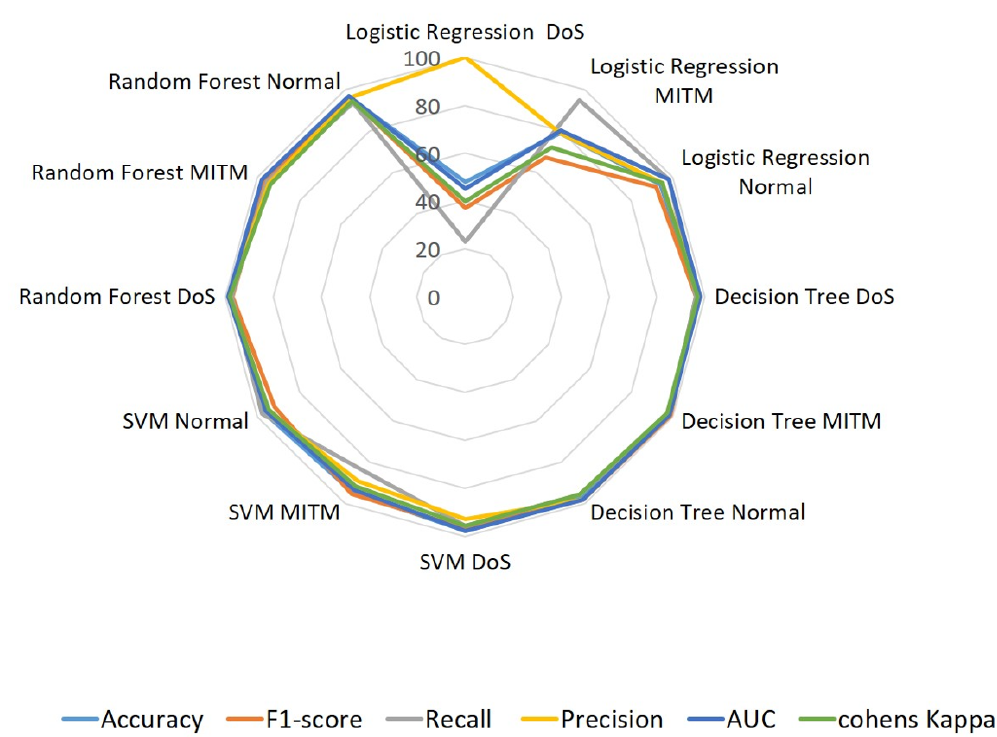
Figure 8. Performances of BLE–supervised ML algorithms. For real-time detection and deployment, neither of the single classifiers gave a better